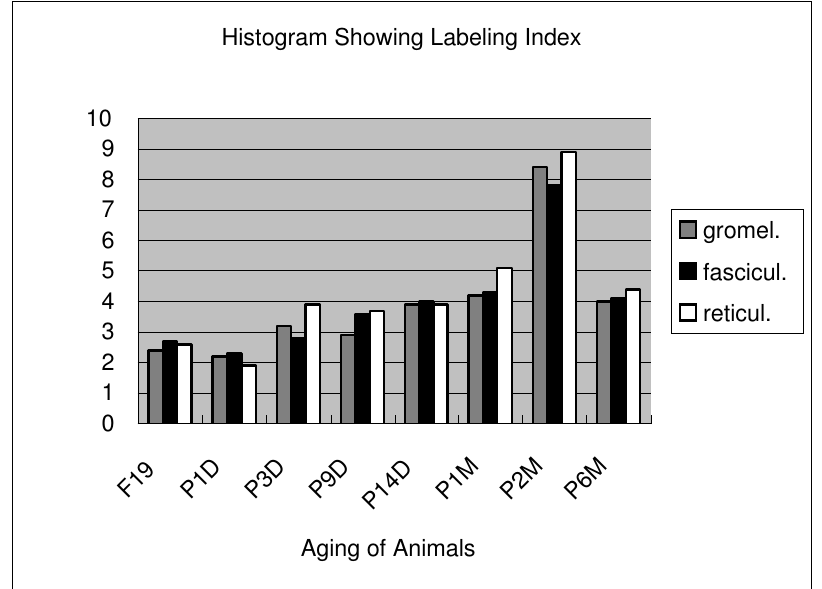
FIGURE 21. Histogram showing the labeling index of mitochondria per each adrenal cortical cell in the three zones of respective animals in eight groups during the development from fetal day 19 to postnatal month 6. The labeling index of mitochondria increased from perinatal stage to adult stage at postnatal month 2, then decreased at month